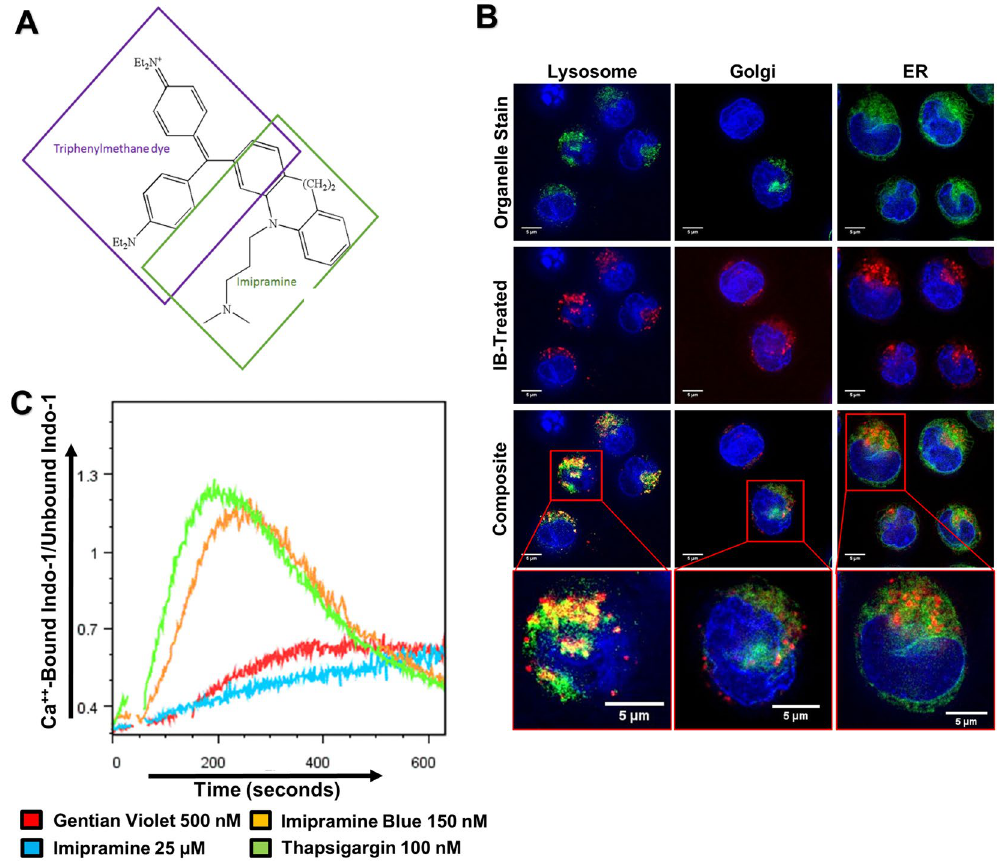
Figure 4. Imipramine blue is trapped in the lysosomes and increases cytosolic calcium concentration comparable to thapsigargin. ( A ) Molecular structure of IB, demonstrating the conjugation of Imipramine to a triphenylmethane dye. ( B ) (Representative result) Live cell imaging of organelle trackers and IB demonstrated a co-localization of 150 nM IB with lysosomal tracker, which was not seen with ER and Golgi tracker. ( C ) (Representative result) IB and the SERCA inhibitor TG caused a surge in cytoplasmic Ca 2 + while Imipramine and Gentian Violet showed minimal effect on Ca 2 +